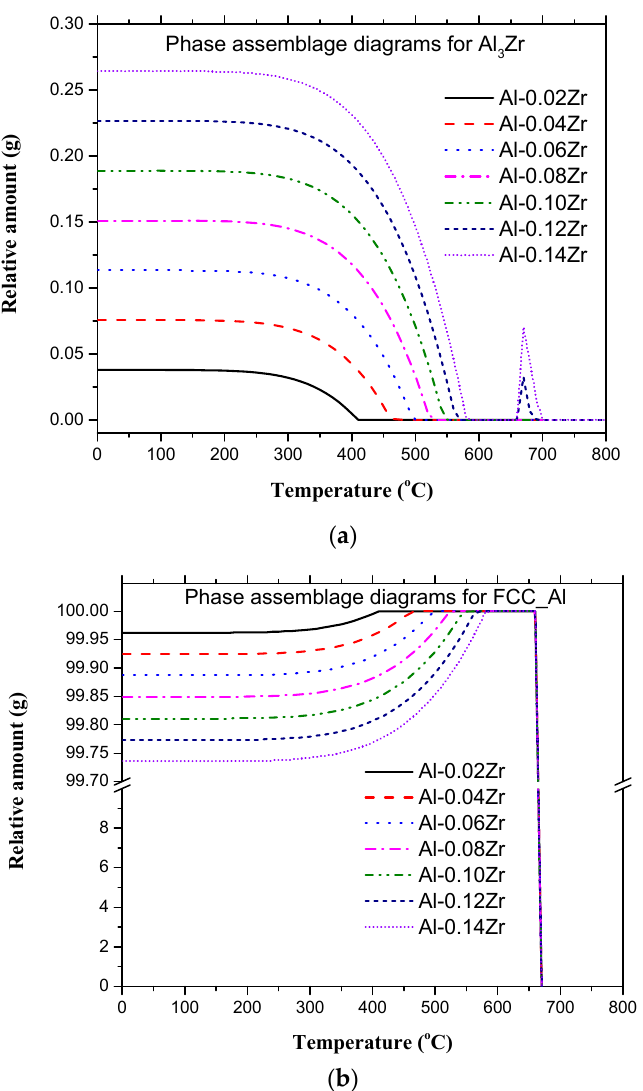
Figure 5. Phase assemblage diagrams for ( a ) Al 3 Zr and ( b ) FCC_Al.